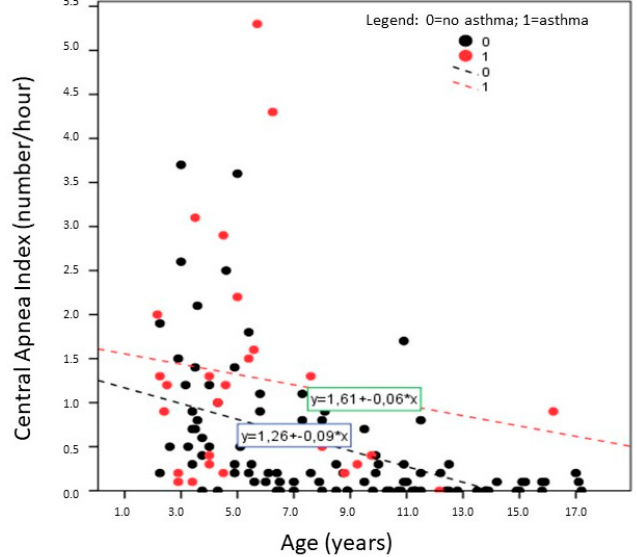
Figure 1. Plotted distribution with regression lines between central apnea index (CAI) and age of the 126 children categorized with recurrent wheeze/asthma (red circle, N = 28) or non-asthma (black circle, N = 98) condition.